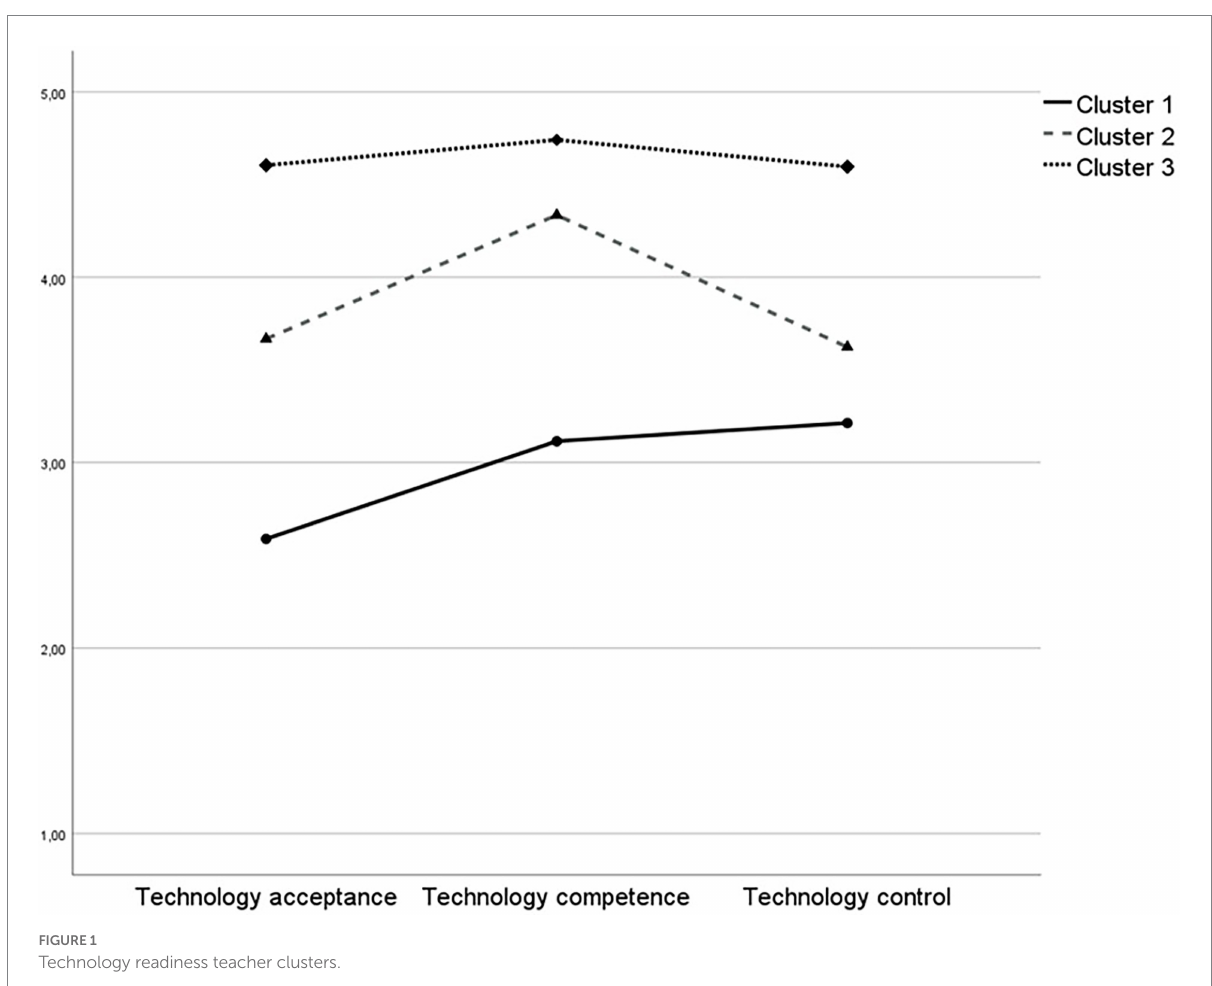
FIGURE 1 Technology readiness teacher